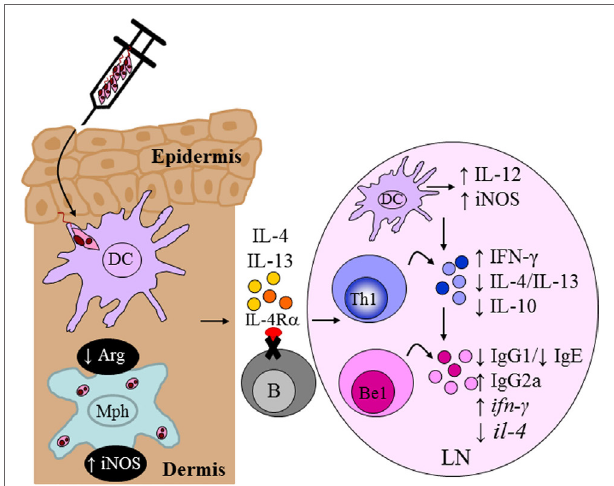
FiGURe 9 | Absence of interleukin-4 (IL-4)-responsive B cells transforms non-healer BALB/c mice to a healer phenotype. Mb1 cre IL-4R α − /lox mice developed an IL-12-induced protective Th1/type I immune response compared to littermate control BALB/c mice following Leishmania major LV39 and IL81 infection in the footpad. IL-4R α -deficient B cells secreted increased ifn- γ and reduced il-4 transcripts, as early as day 1 postinfection, resembling a B effector 1 phenotype in comparison to IL-4R α -sufficient B cells. This in turn led to improved macrophage leishmanicidal functions and control of parasite replication at the site of infection. Illustration prepared from Hurdayal et al. (135). DC, dendritic cells; Mph, macrophage; LN, lymph node; B, B cells; Be1, B effector 1 B cells; Th1, T helper